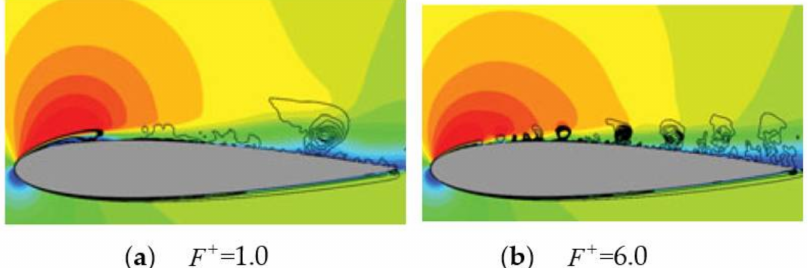
Figure 11. Ensemble-averaged flow fields. Black contour lines are second invariant of the velocity gradient tensors Q-criterion [27]: NACA0015, α = 12 ◦ , BR = 10%, D c = 1.0, Re = 6.3 × 10 4